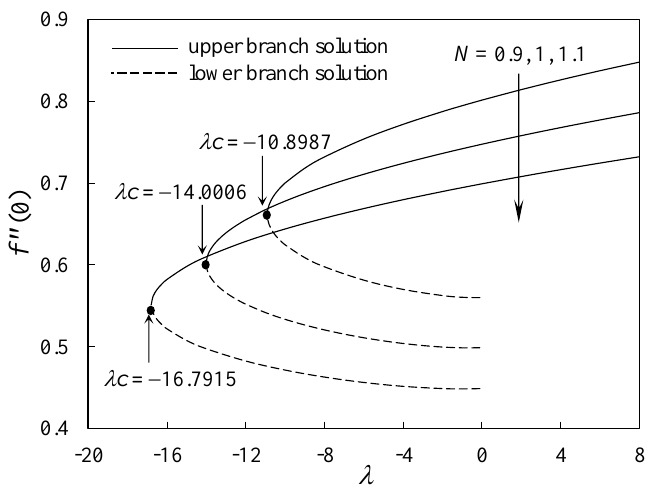
  0 f  with  for several values of N for Ag-water nanofluid. Figure 3. Variation of f (cid:48)(cid:48) ( 0 ) with λ for several values of N for Ag-water nanofluid.